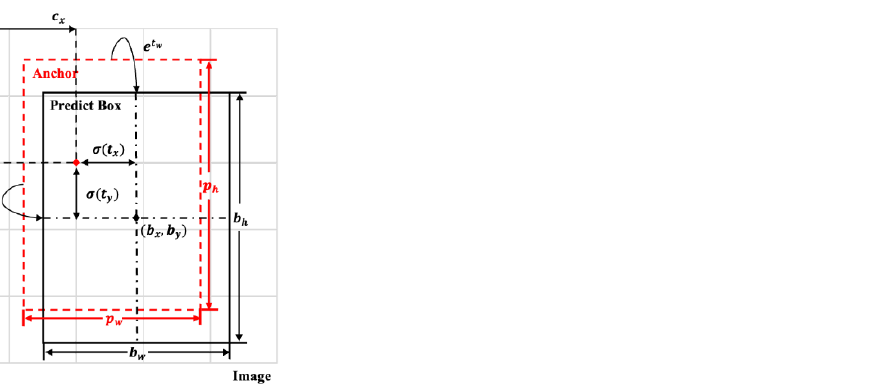
Figure 7. The prediction box generation diagram. The red part represents the position of the anchor box.